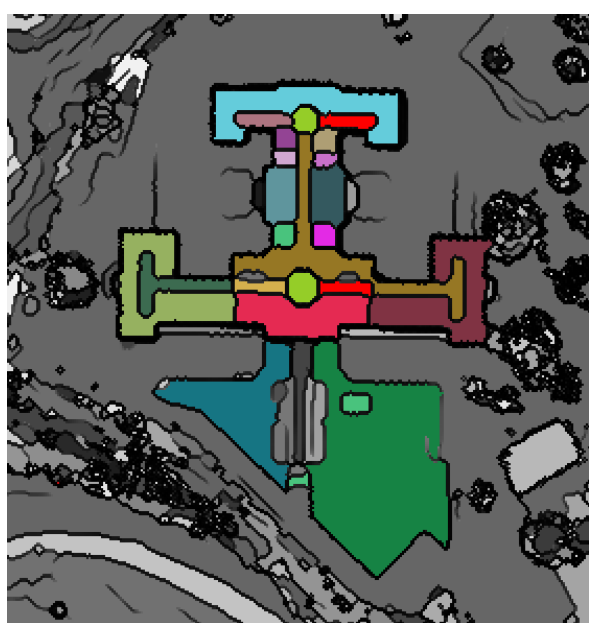
Figure 11: Polygonal shapes (in colors) identified from the anal- ysis of the Blake-Zisserman model applied to the boundaries of the homogeneous regions detected after the application of the Mumford-Shah model to the